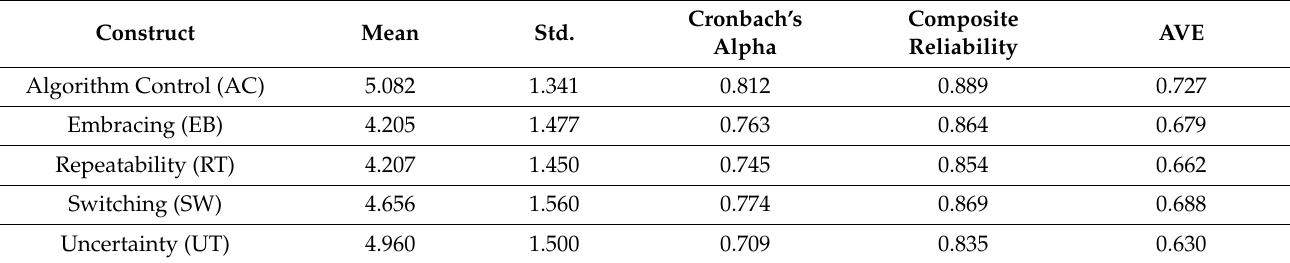
Table 2. Reliability of Each